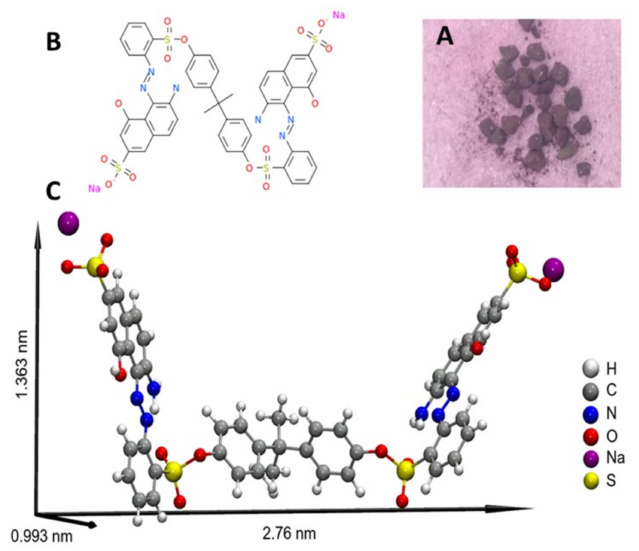
Figure 1. Molecular structure of the Bordeaux dye B: ( A ) photo of the dye shown in granular form, ( B ) image of the one-dimensional molecular structure and ( C ) image of the molecular structure dimensioned in